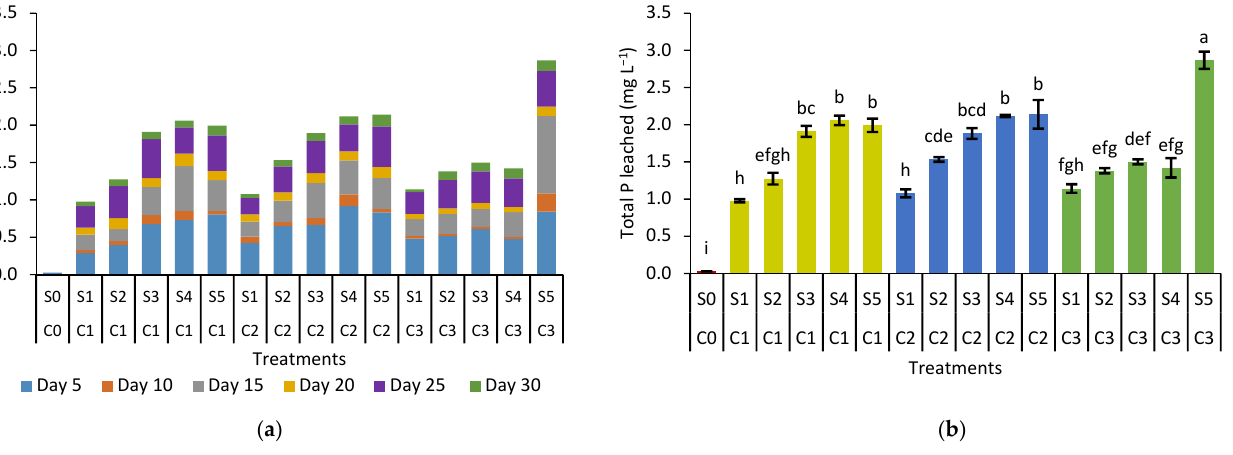
Figure 5. ( a ) Cumulative phosphorus in leachates at five day intervals and ( b ) total phosphorus in leachates for the different treatments after thirty days of leaching. Different letters indicate significant mean differences using Tukey’s HSD test at p ≤ 0.05. Error bars represent the standard error of the mean.